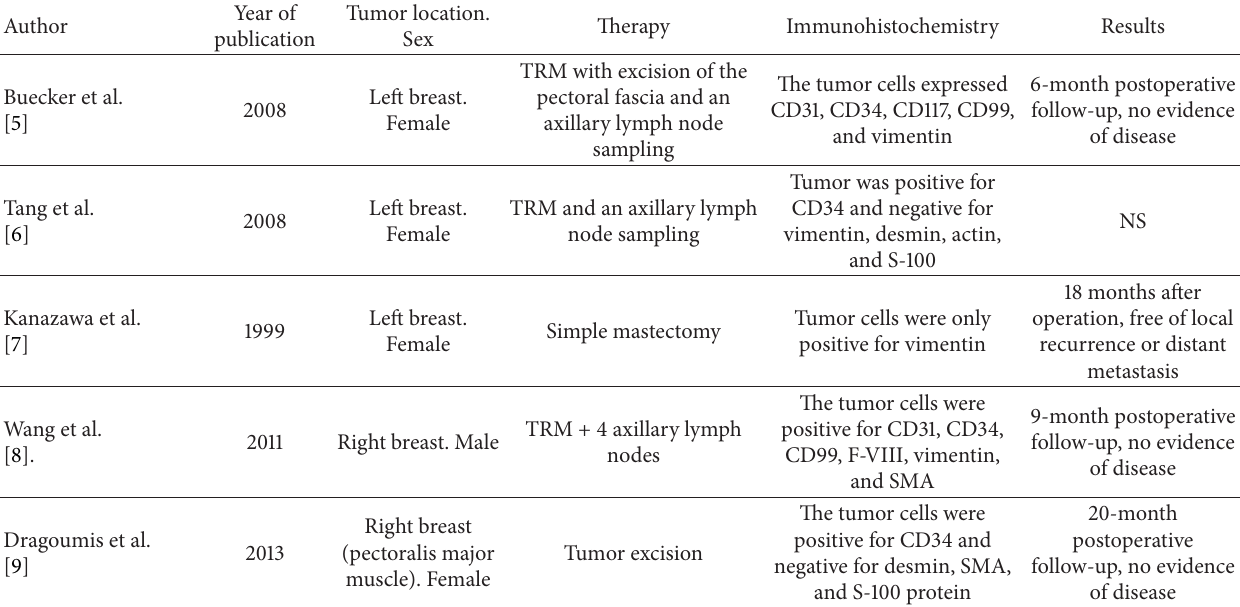
Figure 3: Immunohistochemistry demonstrating the strong expression of the (a) vascular marker CD34 and (b) vimentin by all tumor cells, × 25. Table 1: The most important trials regarding HPC of the